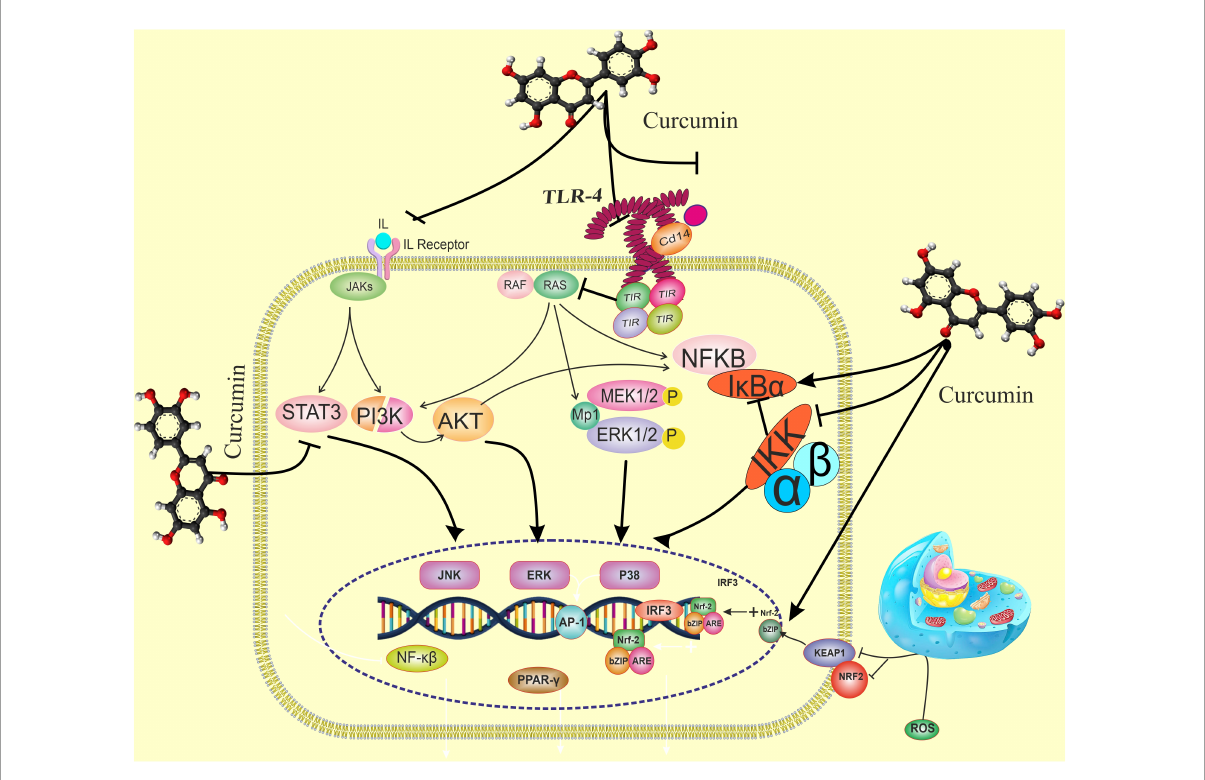
FIGURE3 The effects of curcumin on the immune response pathway. Curcumin can bind directly to MD2 (protein appears to connect with toll-like receptor 4 on the cell surface). Curcumin also inhibits LPS-induced activation of MyD88- and TRIF-dependent TLR4 pathways, resulting in suppression of both IRF3 and NF-B. Curcumin promotes the expression of the Nrf-2 gene by boosting the antioxidant capacity and synthesis of antioxidant enzymes such as SOD, GPX CAT, and CAT. TANK-binding kinase 1; TRAF, TNF receptor-associated factor; TRAM, TRIF-related adaptor molecule; TRIF, TIR-domain- containing adapter-inducing interferon- β , Nrf-2, nuclear factor erythroid 2-related factor 2; p-I κ B α , phosphorylated-I κ B α ; s; ROS, reactive oxygen species, STAT1, signal transducer and activator of transcription 1; TGF-1 β , transforming growth factor- β 1; TIRAP, toll-interleukin 1 receptor domain-containing adaptor protein; TLR4, toll-like receptor 4; TNF- α , tumor necrosis factor- α